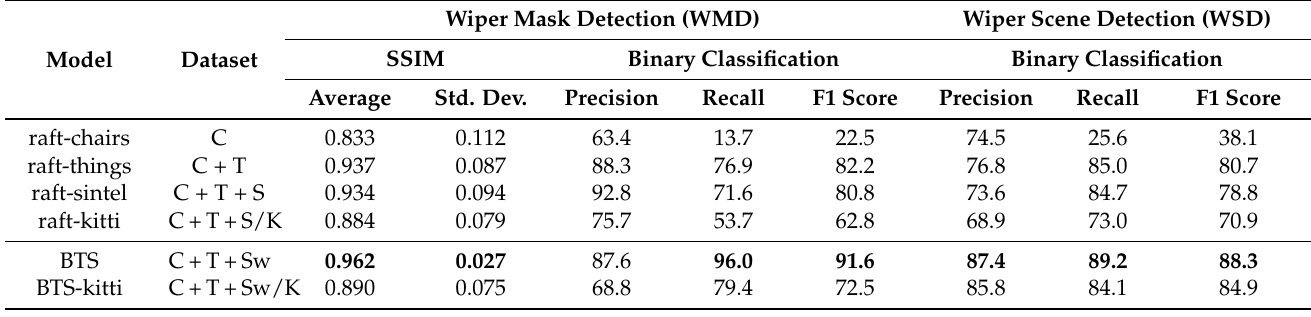
Table 2. Experimental results of SSIM and binary classification (wiper mask and scene detection) in terms of models.